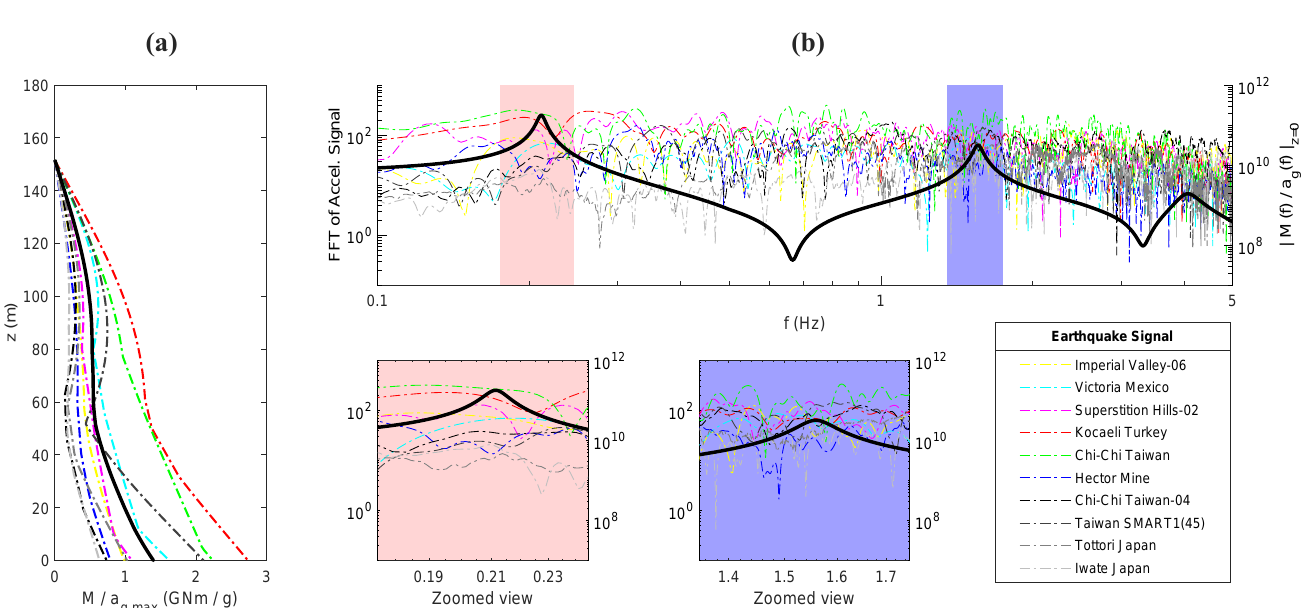
Figure 9. Comparison of the seismic response obtained from different accelerograms. ( a ) Envelopes of maximum seismic bending moments along the superstructure. ( b ) Frequency Response Function of the bending moment at mudline level (solid line) and Fourier Transform of the considered accelerograms (dashed lines). Case: 10 MW, v s = 200